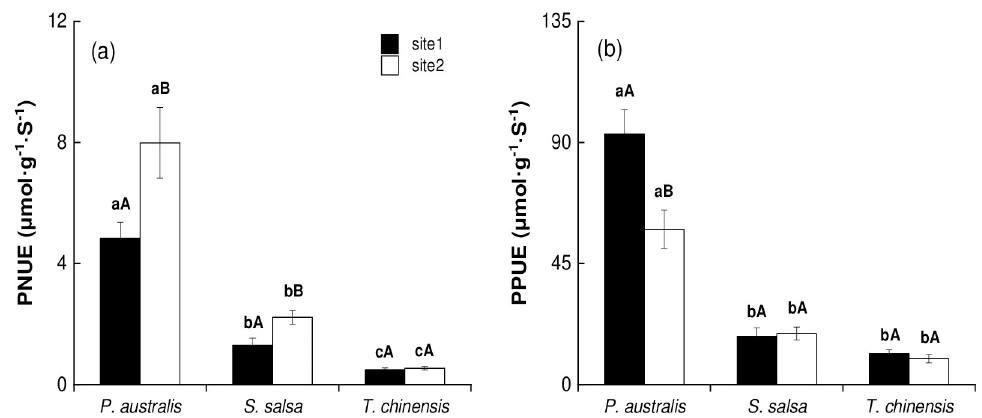
Fig 5. Photosynthetic N and P use efficiency (PNUE and PPUE; mean ± SE) of halophytic plant communities. (a) PNUE; (b) PPUE. The different lower letters indicate significant differences ( P < 0.05) between the different species in the same site; the different upper letters indicate significant differences ( P < 0.05) between the same species in different sites.